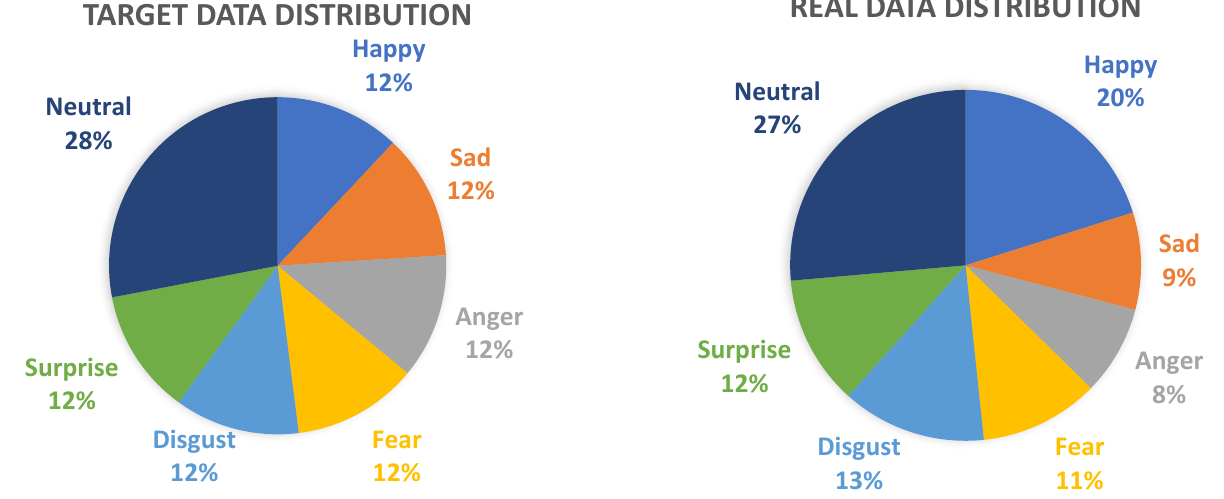
Figure 6. Data distribution of the emotion labels.